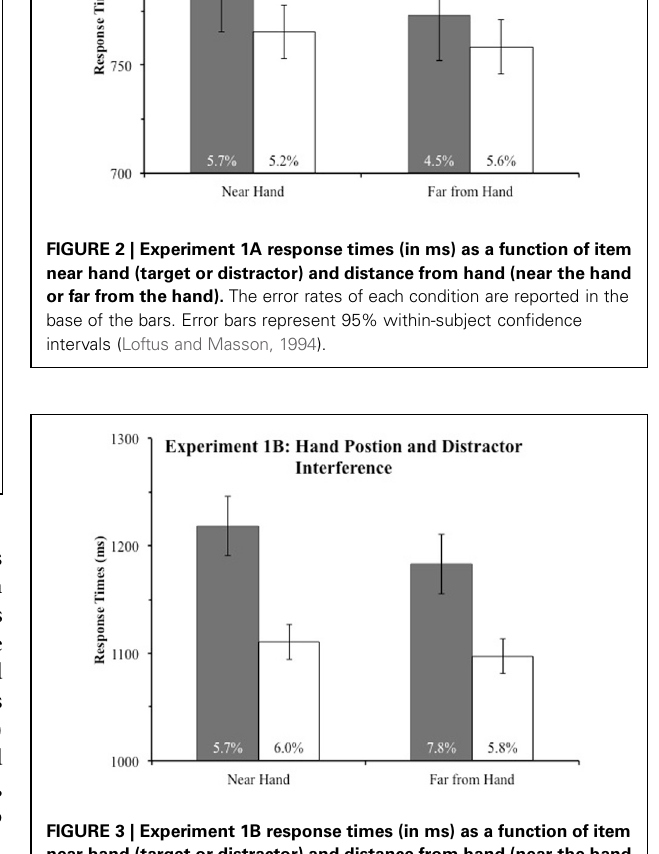
FIGURE 3 | Experiment 1B response times (in ms) as a function of item near hand (target or distractor) and distance from hand (near the hand or far from the hand). The error rates of each condition are reported in the base of the bars. Error bars represent 95% within-subject confidence intervals (Loftus and Masson,